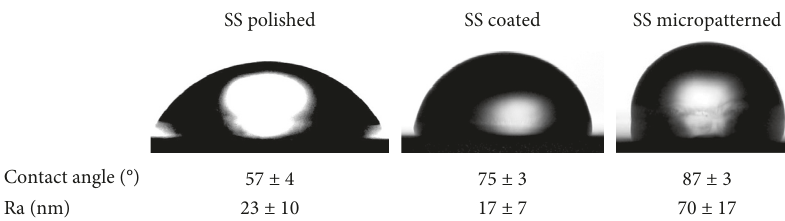
Figure 5: Water contact angles images of SS polished (a), SS coated (b), and SS micropatterned (c) and contact angle and roughness average measurements.